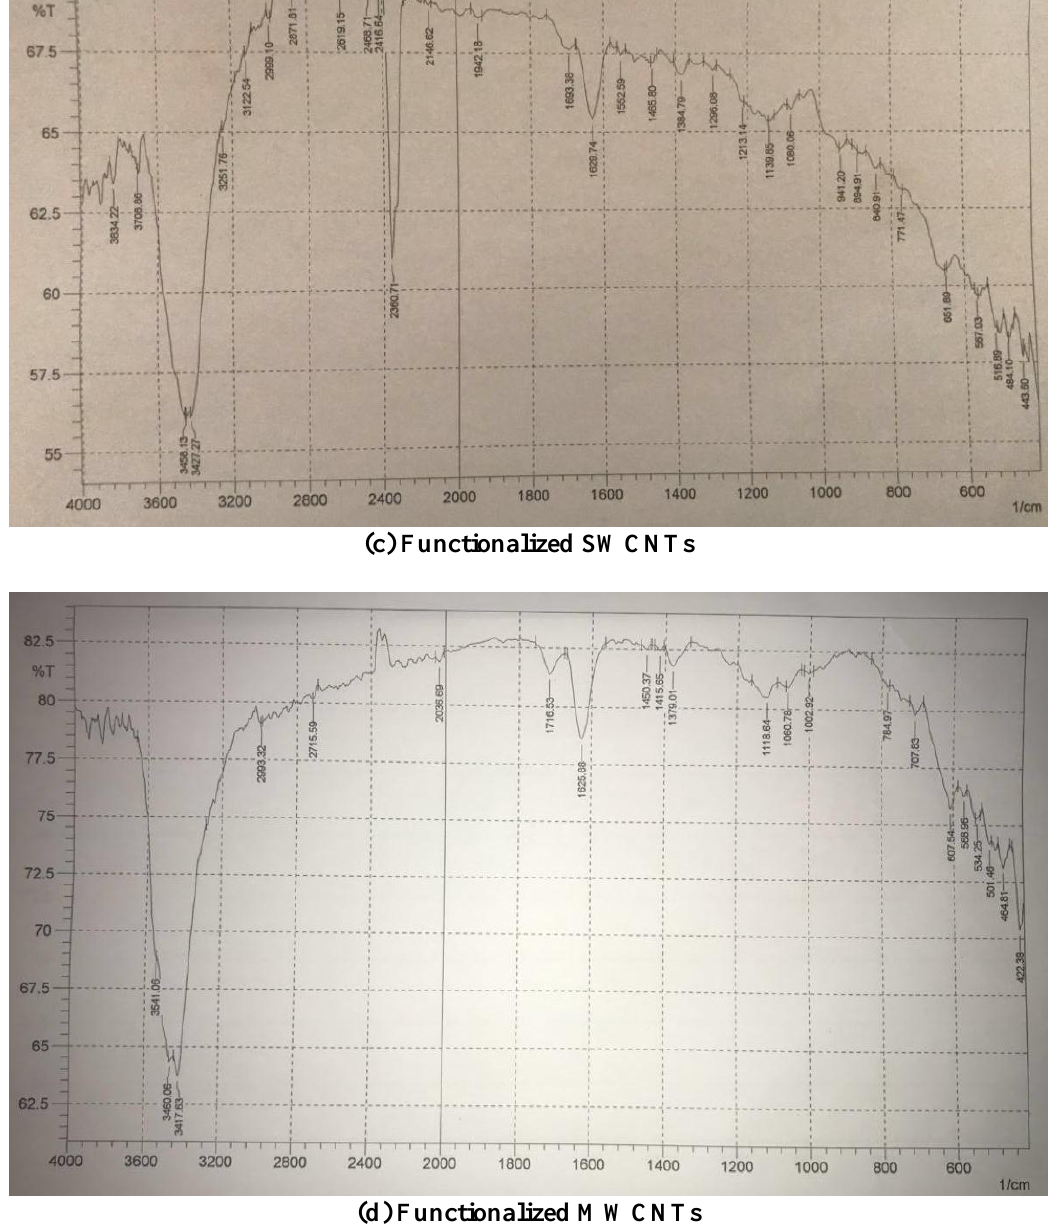
Fig.3: (c) Functionalized SWCNTs by nitric acid and sulfuric acid treatments and (d) functionalized MWCNTs by in nitric acid and sulfuric acid